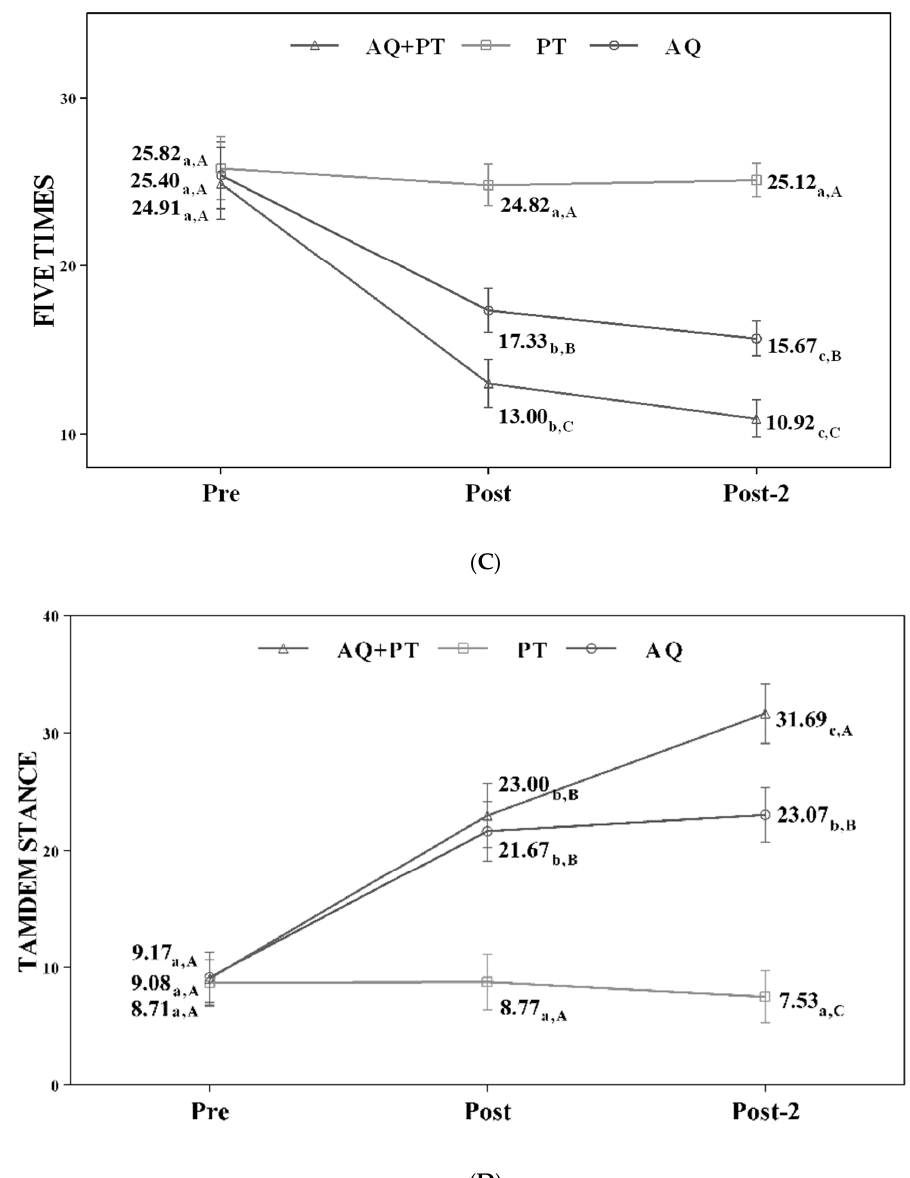
Figure 2. ( A ) Values of Berg balance scale; ( B ) values of the timed up and go test; ( C ) values of the five times sit-to-stand test; ( D ) values of the tandem stance test.